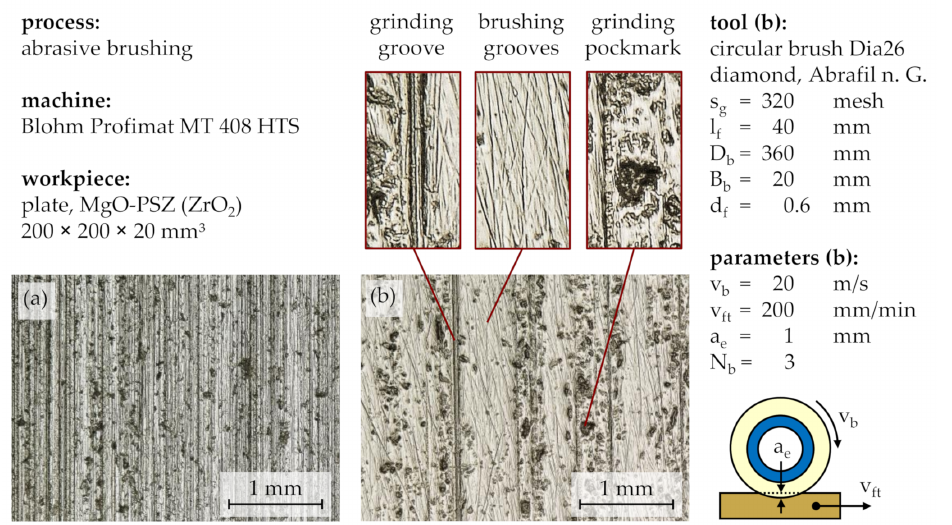
Figure 5. Light microscopy images of ZrO 2 with characteristic surface defects: ( a ) ground surface; ( b ) brushed with abrasive filaments with a filament diameter of d f = 0.6